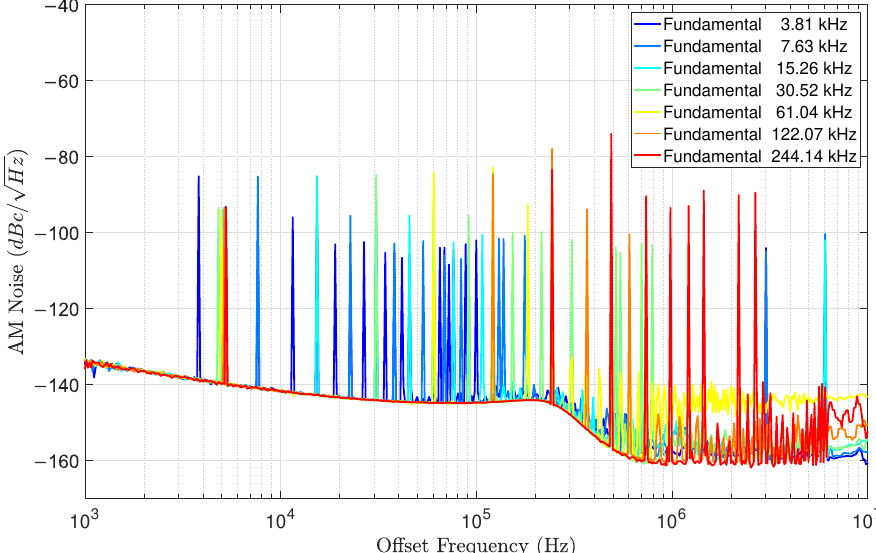
Figure 3. The AM noise spectra of the sinewave modulated test signals generated using the AD9910 DDS for various fundamental